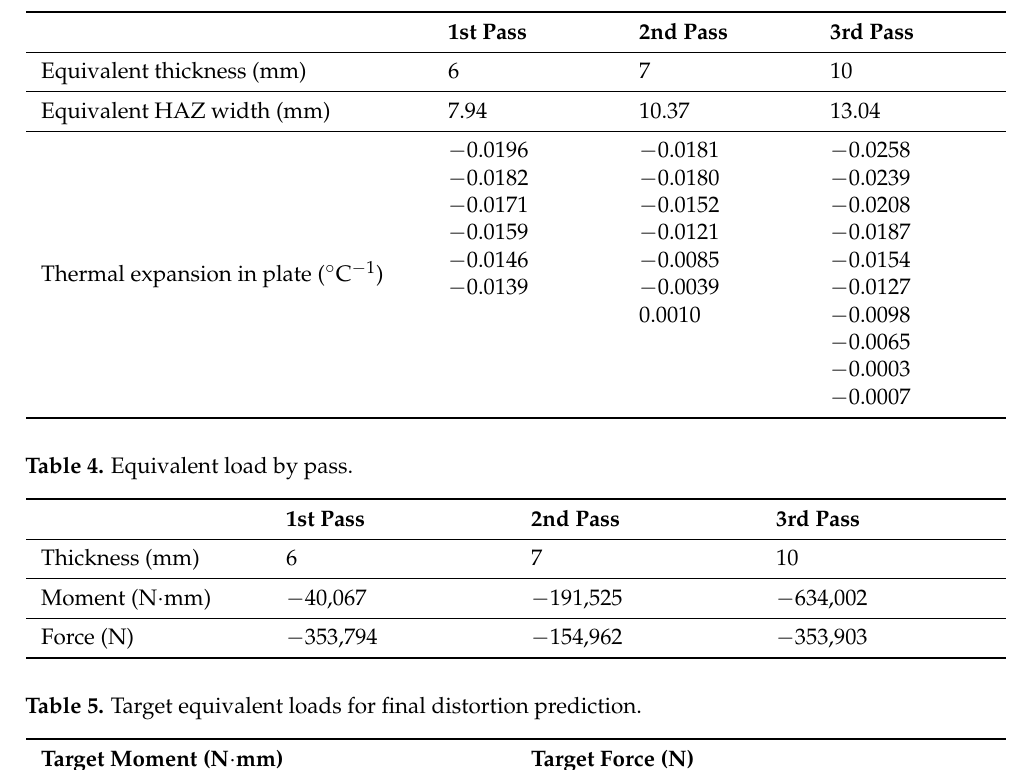
Table 5. Target equivalent loads for final distortion prediction.